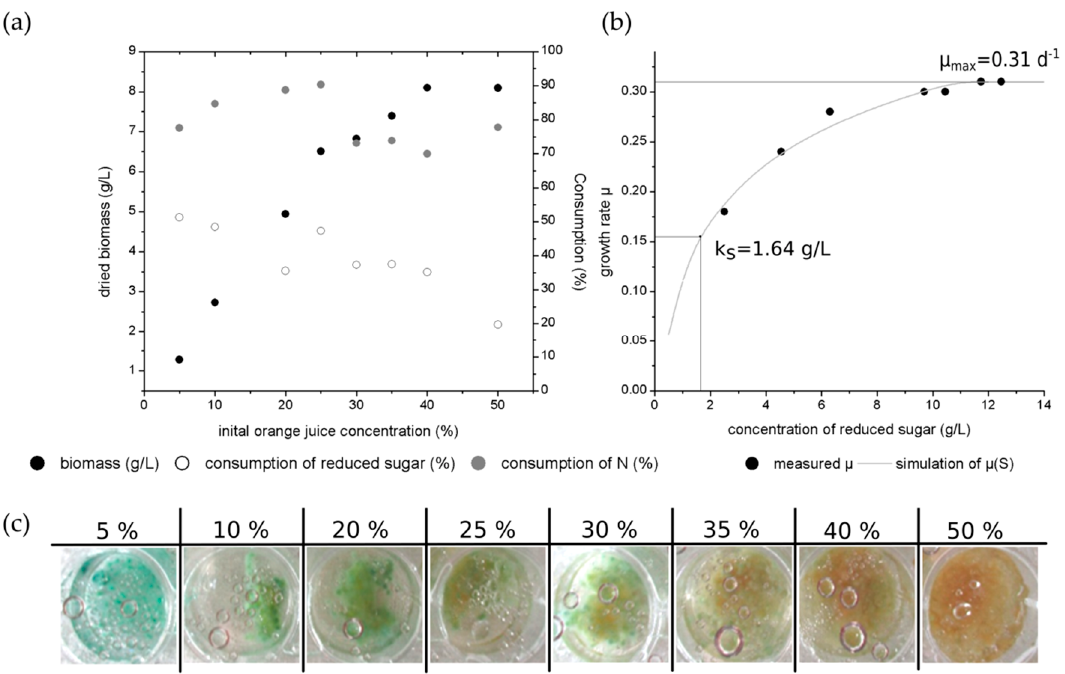
Figure 5. ( a ) Biomass production and consumption of reduced sugars as well as nitrogen in different orange juice concentrations by Chlorociboria aeruginascens. ( b ) Measured growth rate µ over the concentration of the consumed reduced sugars as well as calculated half-velocity constant k S and µ max ( c ) Selected examples of wells with different initial orange juice concentrations (5 %, 10 %, 20 %, 25 %, 30 %, 35 %, 40 %, 50 %).